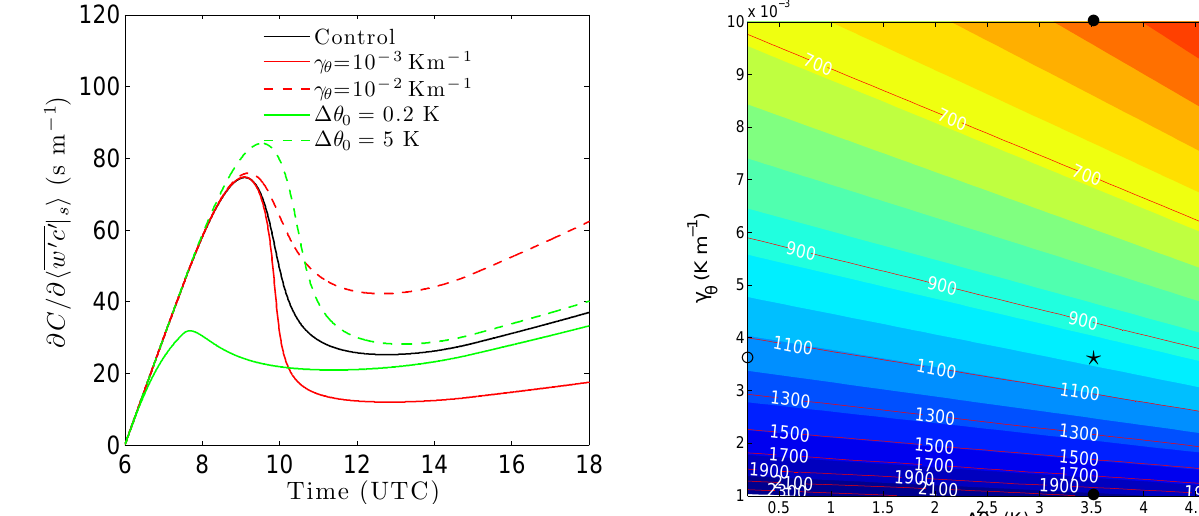
2 mixing ratio D.Pinoetal.: Influenceofconvectiveboundarylayerdevelopmentoncarbondioxidemixingratios Fig. 6. ∂C/∂C 0 (contours) and h (m, red solid lines) averaged be- Fig. 6. ∂C/∂C 0 (contours) and h (m, red solid lines) averaged between 12 and 14 UTC as a function of γ θ and ∆ θ 0 . The control case is shown with ⋆ . Therest of the symbols show the most extreme cases: ◦ ’s ∆ θ 0 =0 . 2 , and 5 Kwith γ θ =3 . 6 10 − 3 and • ’s γ θ =10 − 3 , and tween 12:00 and 14:00UTC as a function of γ θ and 1θ 0 . The con- 10 − 2 Km − 1 with ∆ θ 0 =3 . 5 K. trol case is shown with ? . The rest of the symbols show the most extreme cases: ◦ ’s 1θ 0 = 0 . 2, and 5K with γ θ = 3 . 6 × 10 − 3 and • ’s γ θ = 10 − 3 , and 10 − 2 Km − 1 with 1θ = 3 . 5K. 0